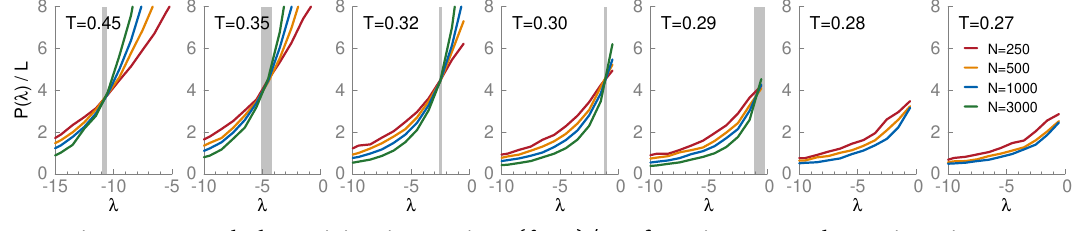
Figure 3: Scaled participation ratio P ( λ , N ) / L of stationary and quasi-stationary points of the ternary mixture model from W -minimizations for all studied tempera- tures and system sizes N . The mobility edge λ is the eigenvalue at which P ( λ , N ) / L e has a fixed point and is indicated by a vertical bar. The width of the vertical bar corresponds to the uncertainty on λ . e